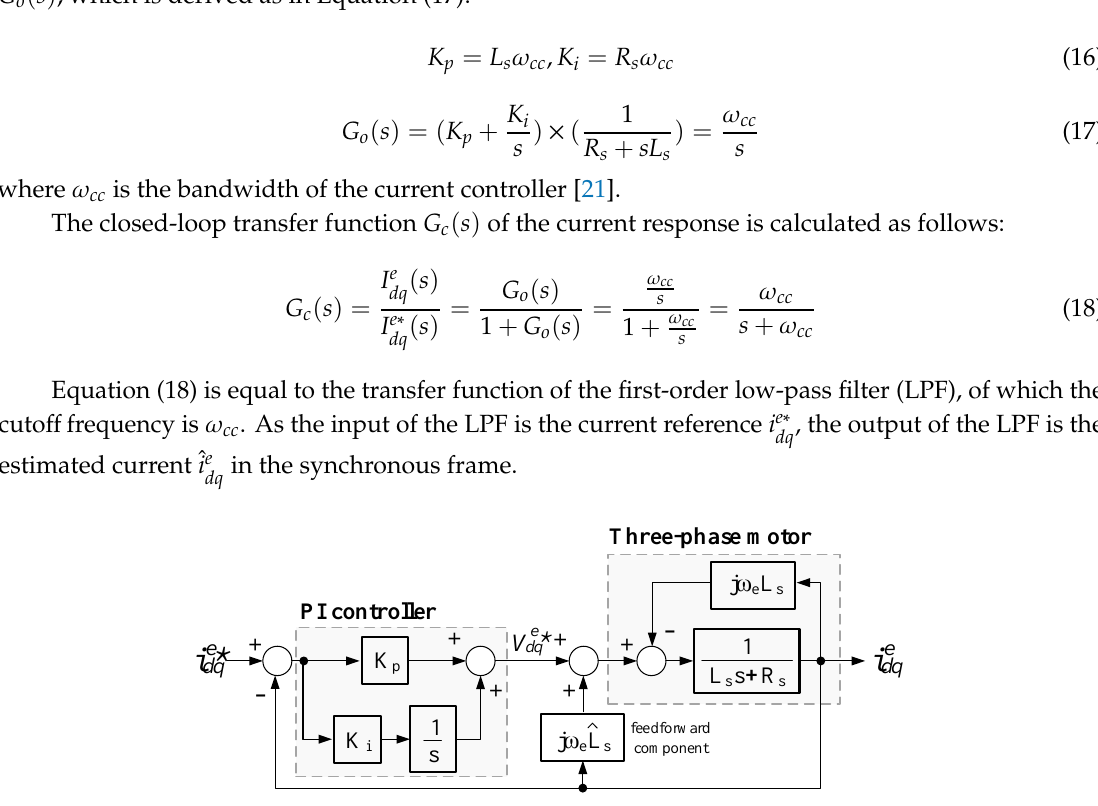
Figure 7. Block diagram of the PI current controller and the motor.